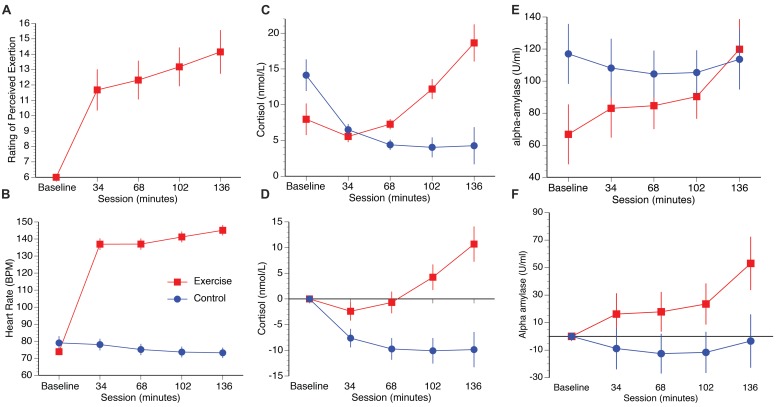
Plots illustrate RPE (A), heart rate (B), raw cortisol and alpha-amylase data (C,E), and cortisol and alpha-amylase data corrected to baseline (D,F). Error bars represent SEM.